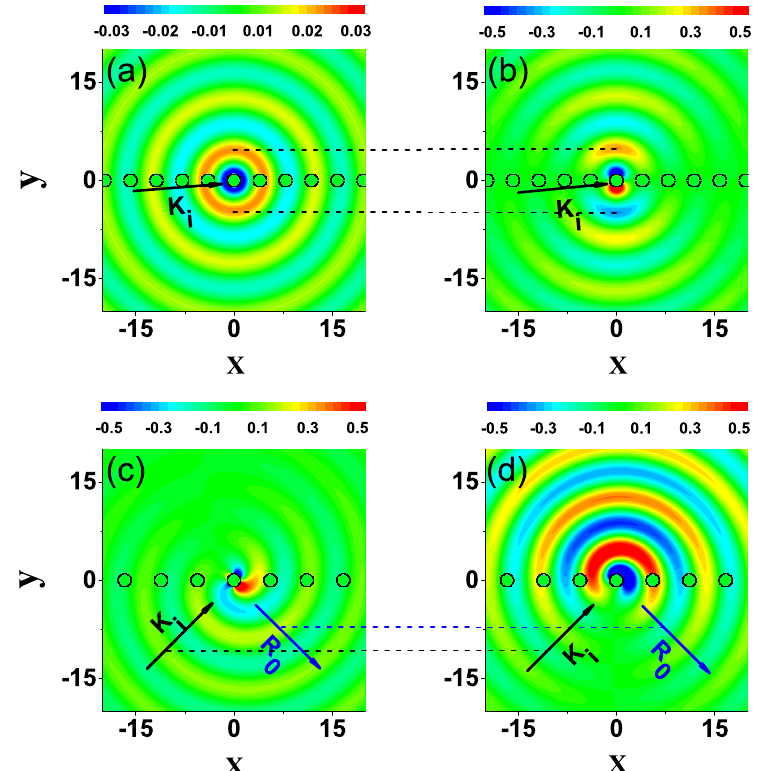
Fig. 5 Elimination of the ordinary and -1st-order re fl ections at θ WA = 5° and 45°. The scattered fi eld distribution contributed ( a ) by the channel n = 0 correspondings to an isotropic mode and ( b ) by the channels n = − 1 and 1 corresponding to a standard dipole mode at θ WA = 5°. The scattered fi eld distribution contributed ( c ) by the channels n = − 2 and − 1 and ( d ) by the channels n = 0 and 1 at θ WA = 45°. The calculation is performed for the same QD with the inter-QD interaction considered as in Fig. 4. K i and R 0 denote the incident and ordinary re fl ection directions,